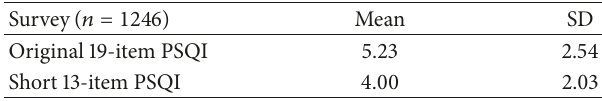
Table 2: Agreements tests between “good” and “poor” sleeper scored by original and “shortPSQI.”